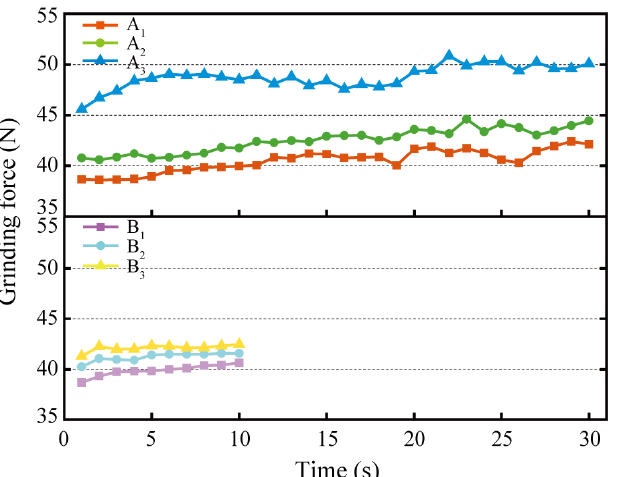
Figure 10. Grinding forces of grinding wheels on rail samples under different grinding times.